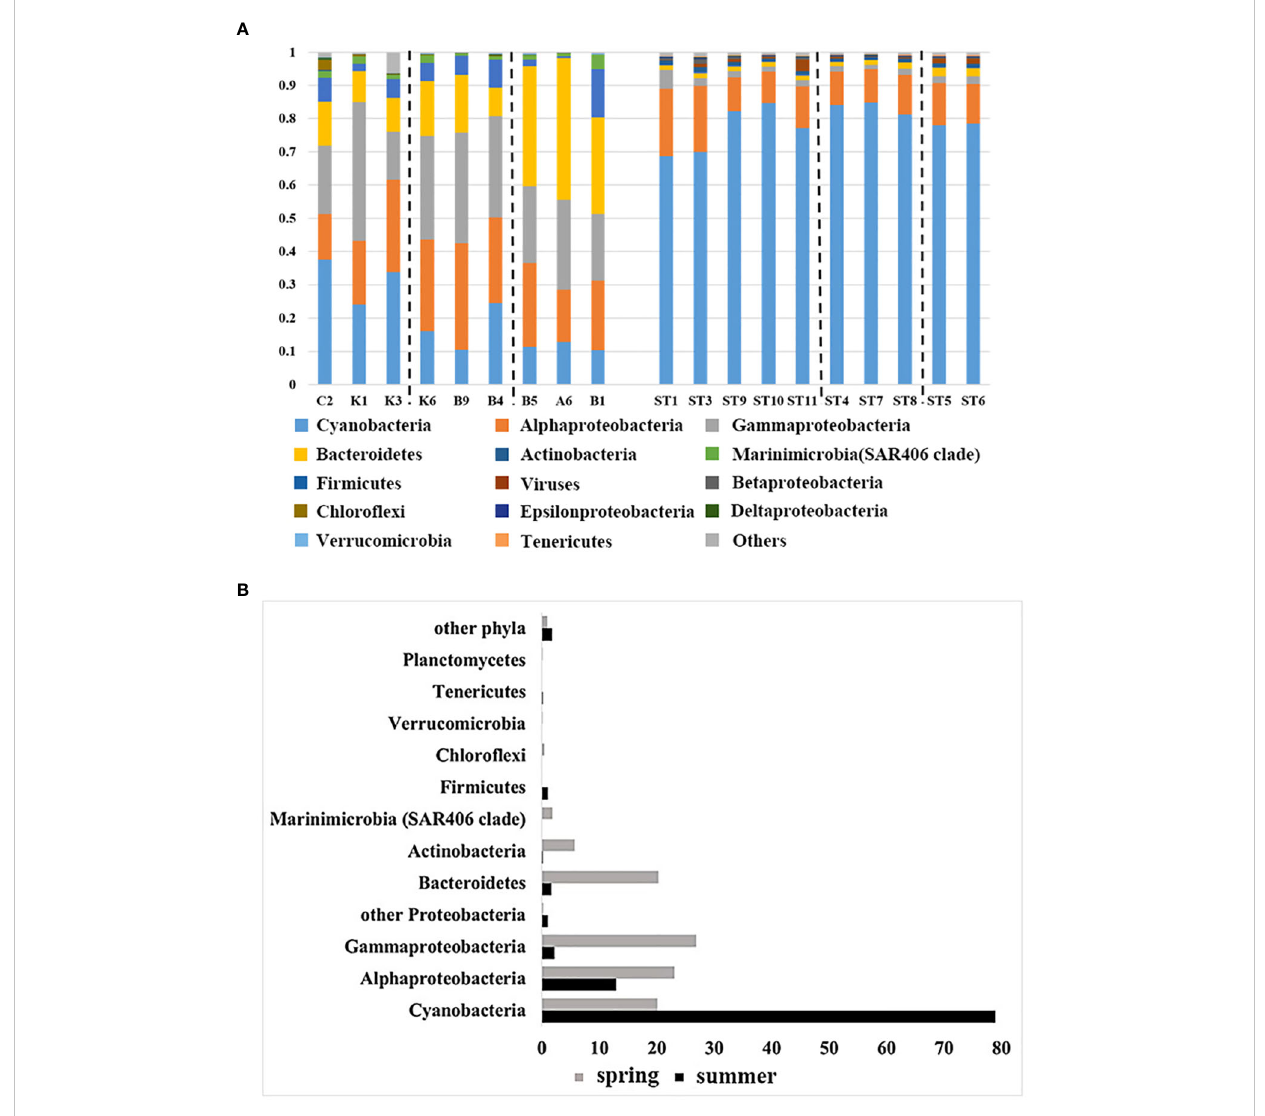
FIGURE 7 Comparison of community composition (A) during the spring cruise in 2015 (left) and the summer cruise in 2018 (right) in the NWPO (only the relative abundance of the top 15 phyla is listed) and comparison of the relative abundance of the top 12 phyla(class) (B) during the two